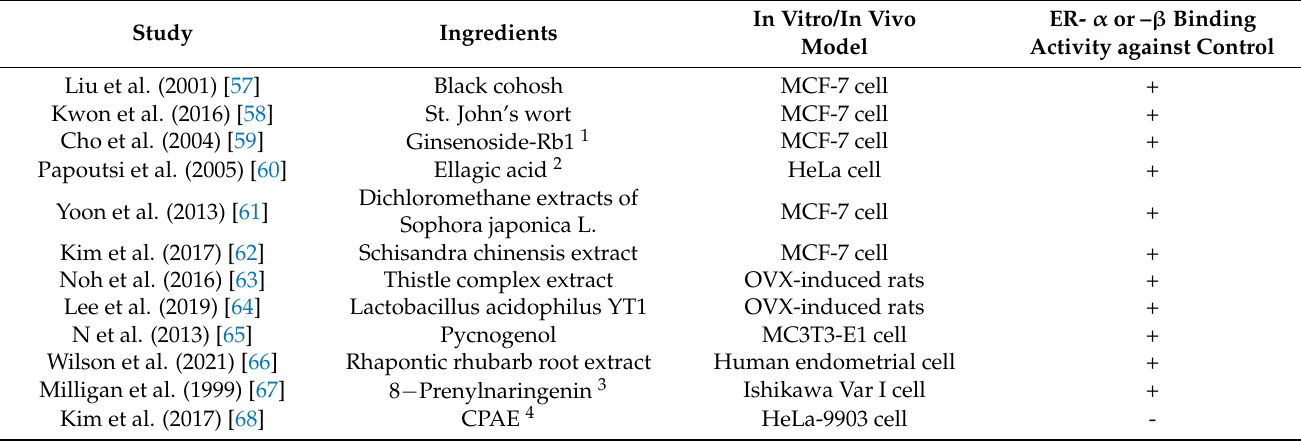
Table 1. ER binding activity of the functional health ingredients for women in menopause.